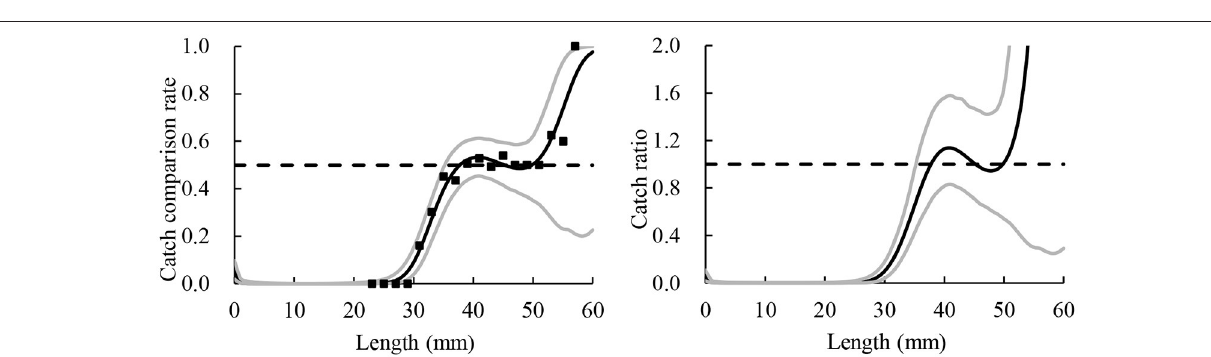
FIGURE 4 | Catch comparison rate (left column) and catch ratio (right column) for krill for the LT’s trawl vs. the FRH’s trawl. The square marks represent the experimental rates. The thick black curve represents the modeled rate, and thin stippled curves represent the corresponding 95% confidence limits. The horizontal black stippled line shows the expected rate in case of no difference in catch efficiency between